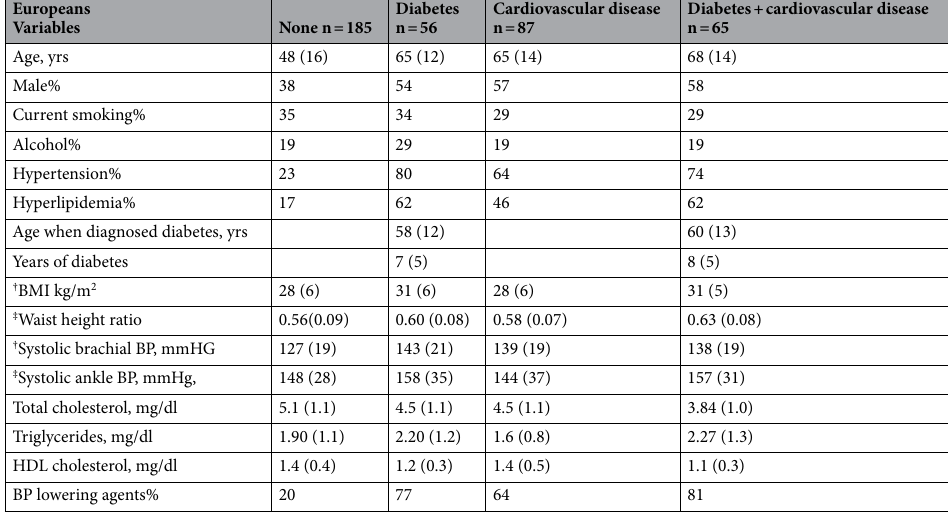
South Asians Variables